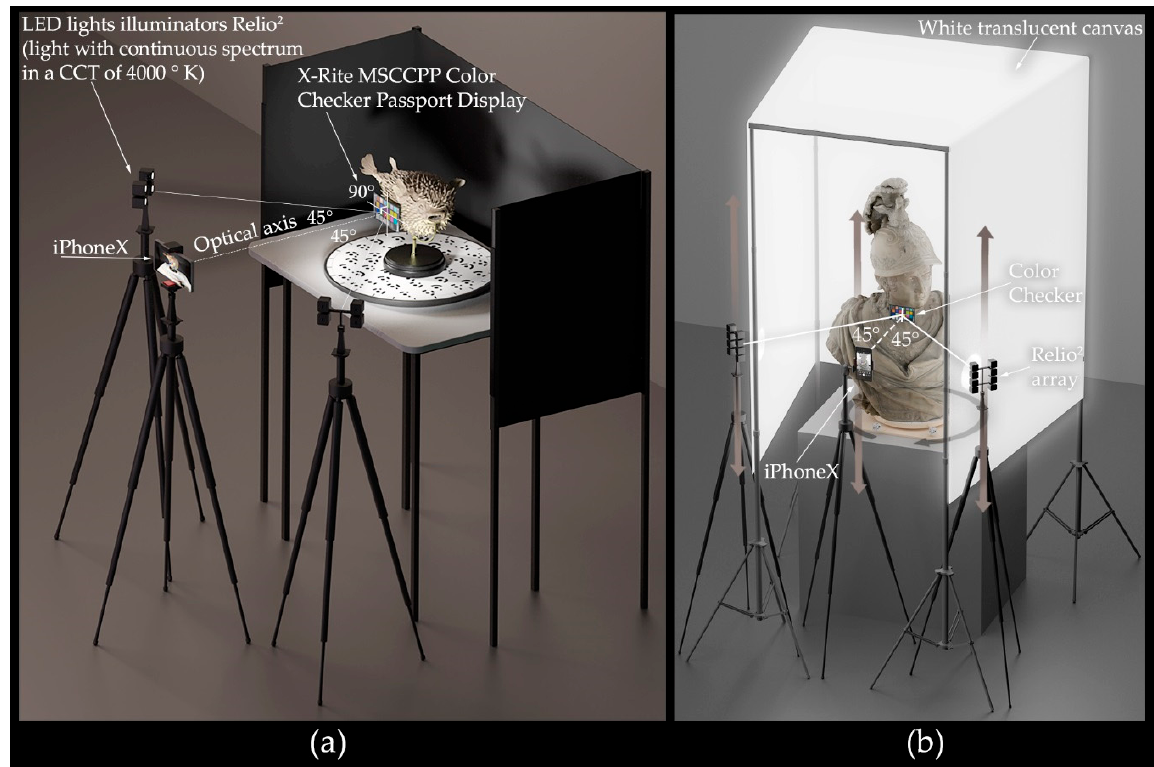
Figure 3. Acquisition set: led light illuminator kit with Relio2 ( a ); white translucent canvas box ( b ). In both figures, the rotating support with coded target cubes radially placed along its thickness is visible.